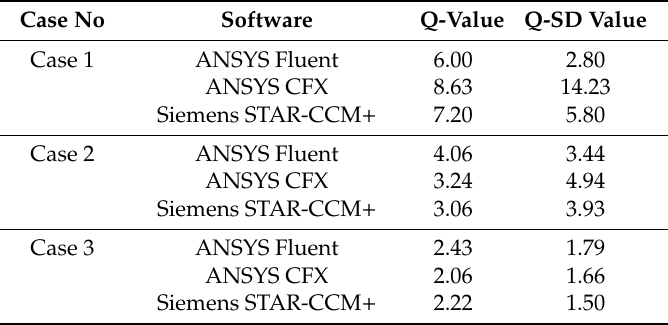
Table 8. Q-Values with their Corresponding